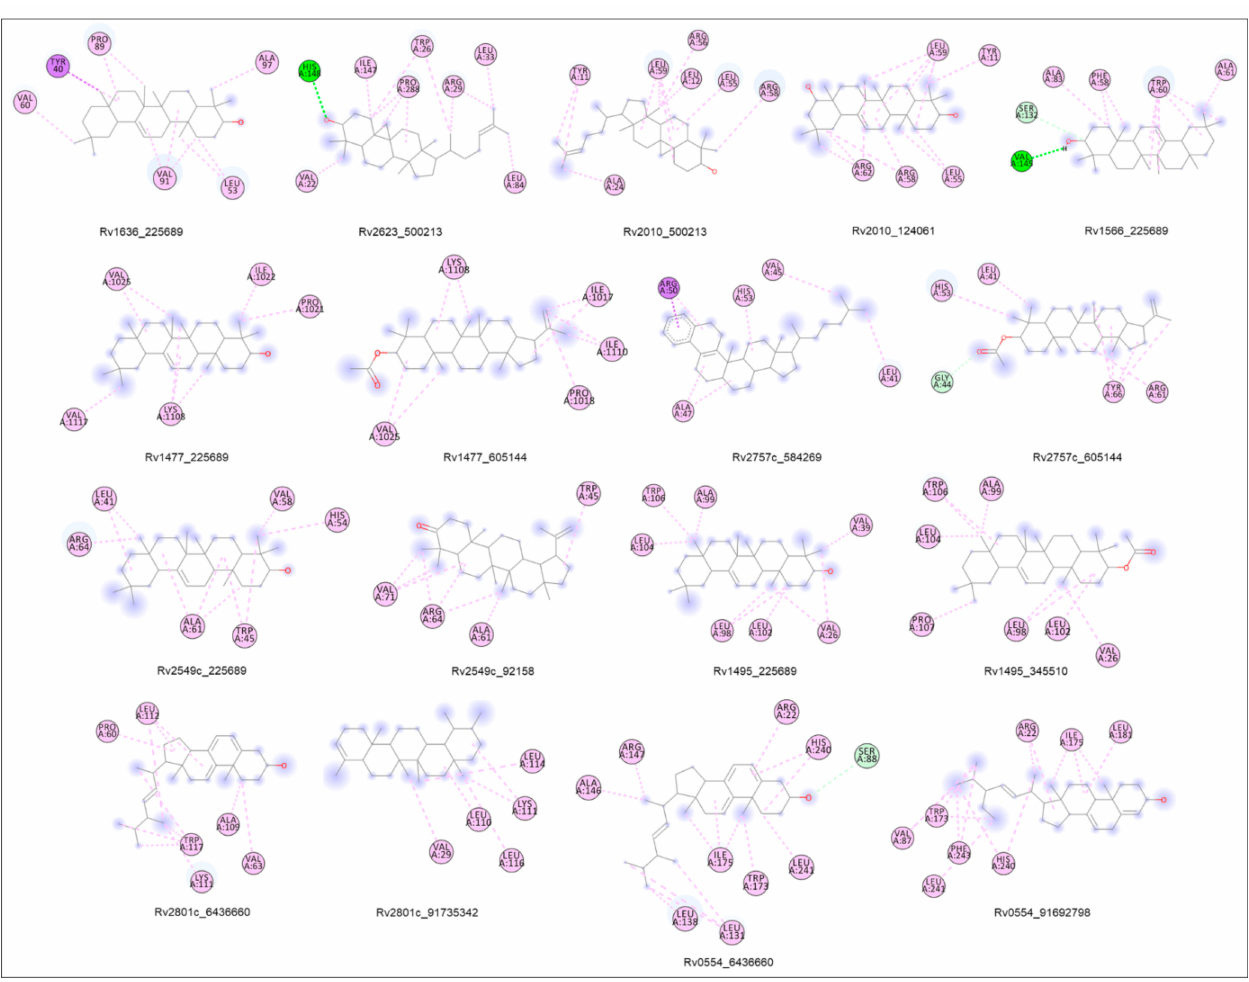
Figure 7. Comparative docking score analysis of the VDA proteins against top hit phytoconstituents.